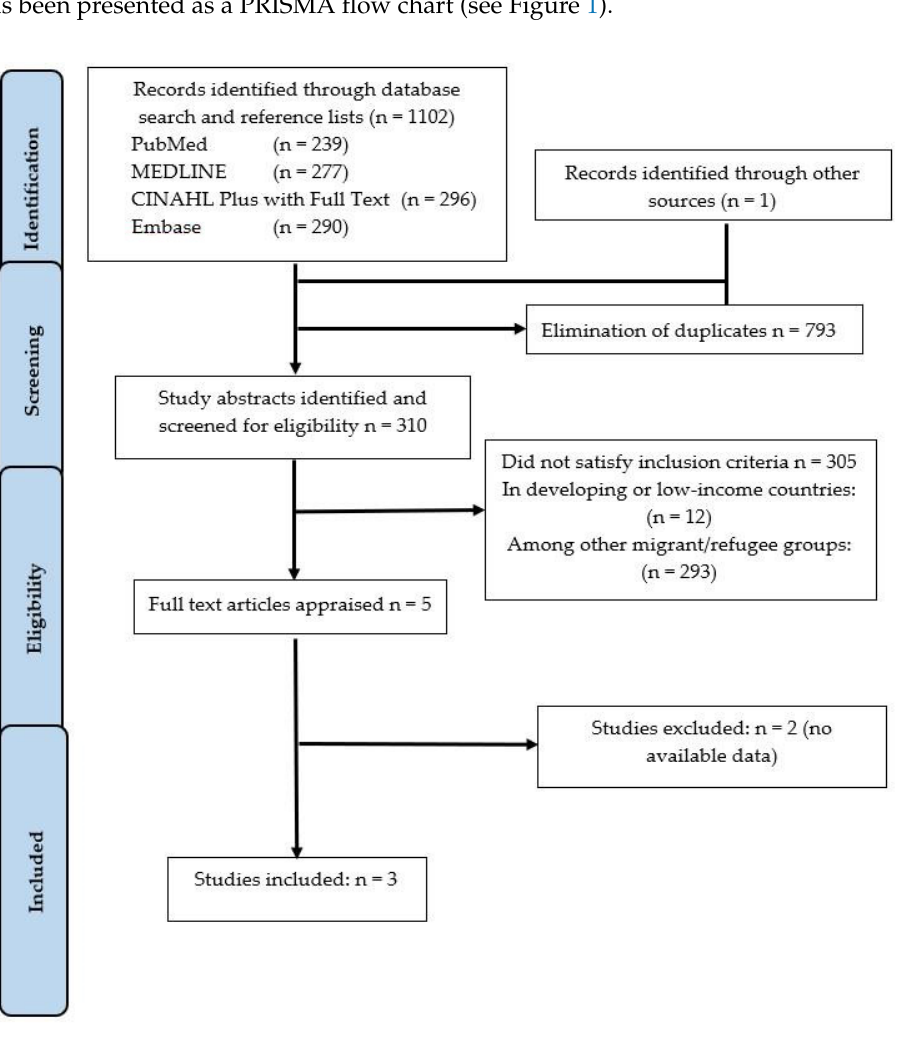
Figure 1. Preferred Reporting Items for Systematic Reviews and Meta-Analyses flow chart of the literature search and study selection